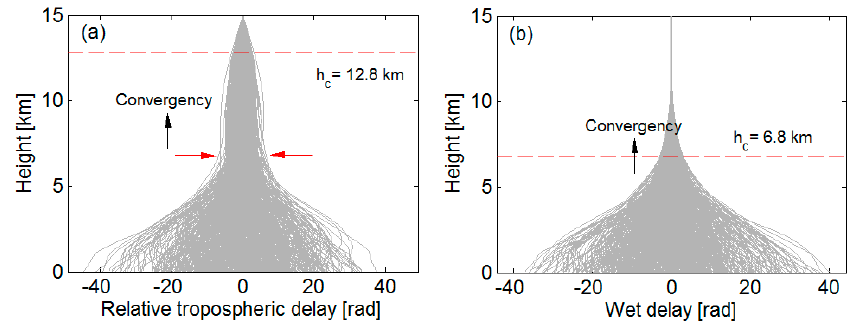
Figure 7. ( a ) Relative tropospheric delays computed from ERA-I reanalysis in California for 120 days (18:00 UTC) between June and October 2009. Relative delay curves are 800 combinations of the tropospheric delay difference at different days, covering the acquisition for interferogram 20090627/20090905 (example in Figure 3). The relative delays did not change significantly at certain height (red arrows) and converged (red lines) at a specific height h c of 12.8 km. The STD of the relative curves is less than 1 rad. ( b ) Wet delays converged at the height of 6.8 km. The delays are calculated by integrating the refractivity from surface upward (15 km) and projecting to LOS direction.